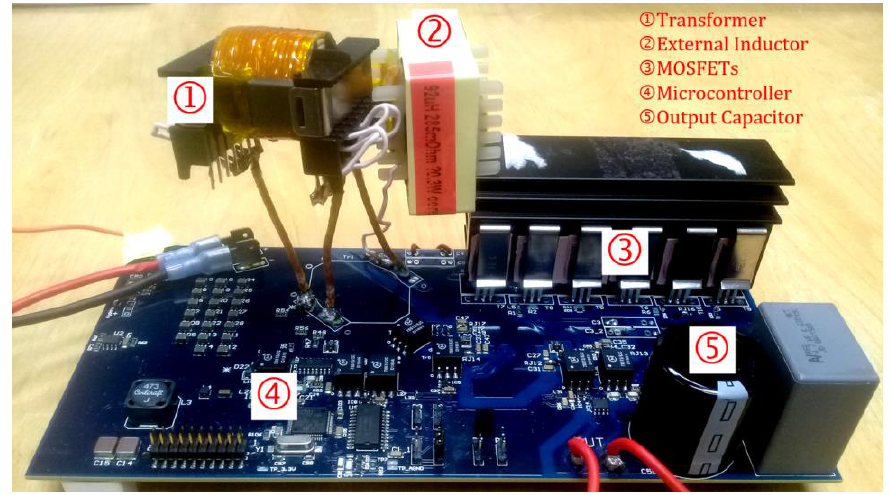
Figure 9. Photo of the experimental prototype. Table 1. Experimental setup parameters and